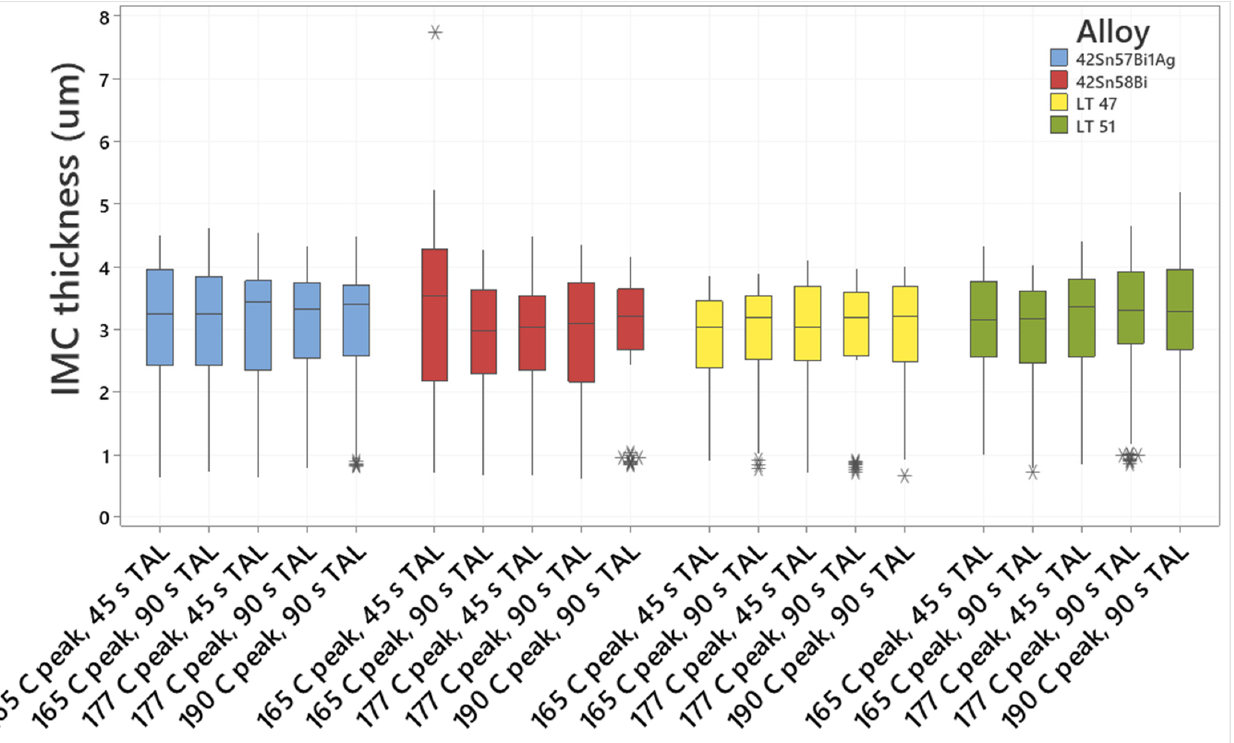
Figure 13. Boxplot of intermetallic thickness in PCBs reflowed with Sn–Bi alloys. Sn58Bi, 42Sn57Bi1Ag and LT 47 show a similar appearance. Both contain large la- mella-like bismuth rich phases (white) and tin-rich phases (grey). While LT 51 also con-